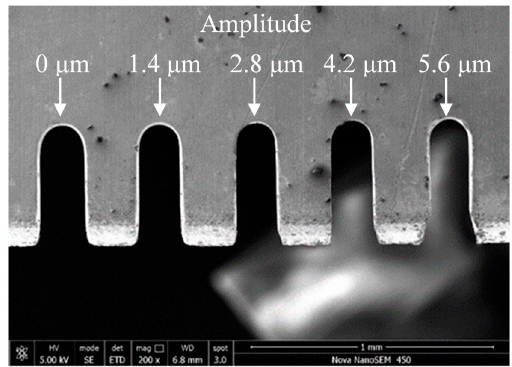
Figure 9. Microslits under different vibration amplitudes.